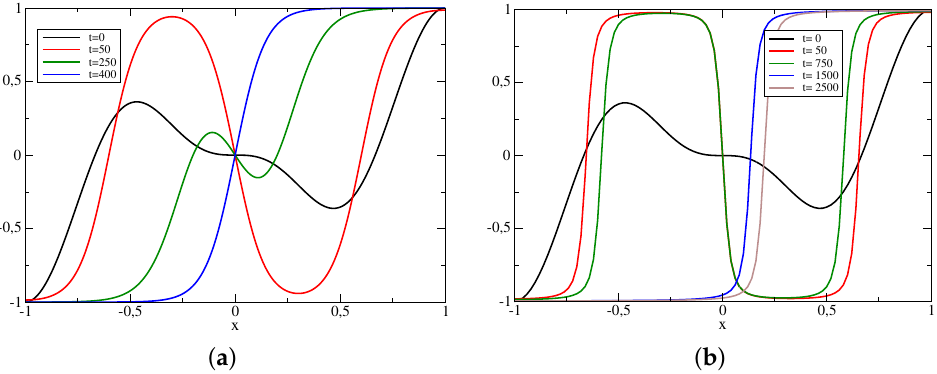
Figure 3. Dynamics of the solutions of the Allen–Cahn equation for varying the fractional power parameter: ( a ) the classical diffusion process α = 1, ( b ) the fractional diffusion process α =